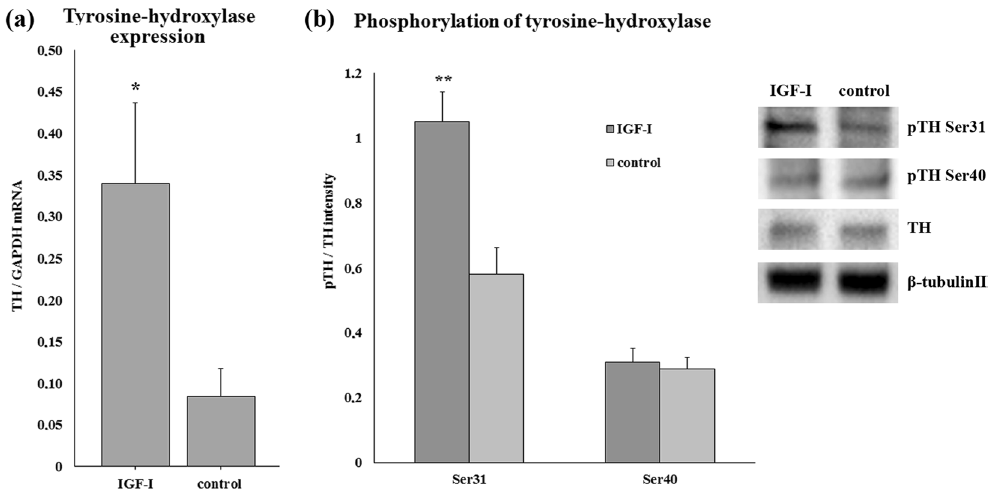
Figure 7. IGF-I treatment enhances the expression of TH and its phosphorylation on phosphorylation site Ser 31 in primary mediobasal hypothalamic cell cultures. ( a ) The TH mRNA expression was approximately fourfold higher in cell cultures treated with IGF-I (12.5 µ g/ml) for 4 days compared with that in controls (p = 0.048). Data are expressed as the ratio of GAPDH mRNA levels (n = 4 in both groups). ( b ) Following incubation with or without IGF-I (12.5 µ g/ml) for 30 min, the cells were lysed, and the phosphorylation of TH at the Ser 31 and 40 residues was determined using phosphorylation site-specific antibodies. Data are expressed as the ratio of TH intensity. The panels beside the diagram show representative images of immunoblot bands. Western blot results show that IGF-I treatment significantly increased the phosphorylation of TH at the Ser 31 residue (p = 0.003). There was no difference between the two cultures at the Ser 40 phosphorylation site (n = 6 for both groups). The results are presented as the mean values ±